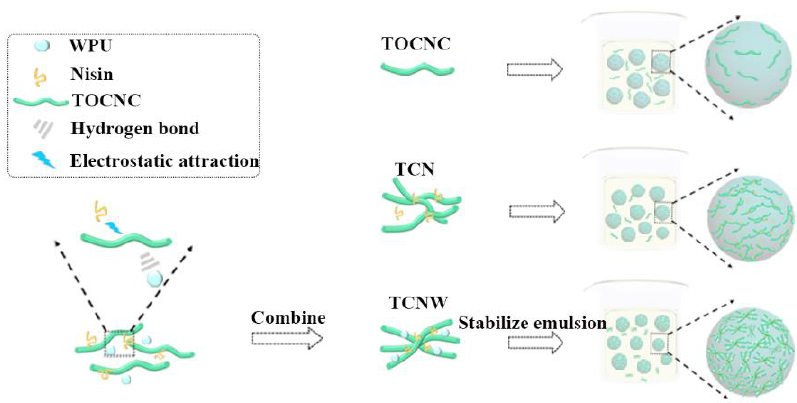
Figure 6. Adsorption of TOCNC, TCN and TCNW particles on emulsion droplets.